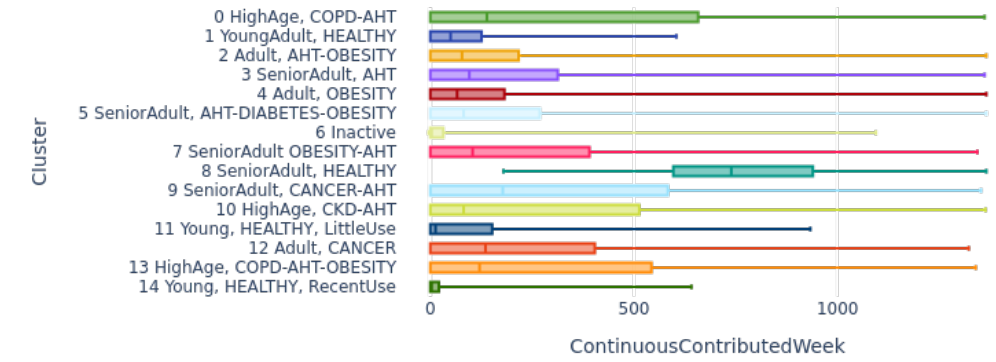
Figure 11. Distribution by cluster of continuous contributed weeks.